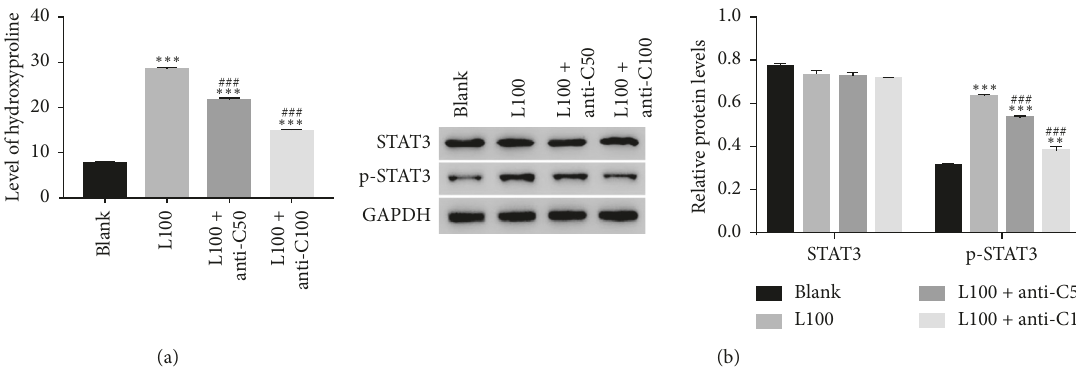
Figure 6: The antibody of CXCL16 reduced the effect of LPS on mouse LF cells. (a) The antibody of CXCL16 deeply suppressed the production of HYP in LPS cultured cells ( ∗∗∗ p < 0 . 001 vs Blank; ### p < 0 . 001 vs L100). (b) The phosphorylation of STAT3 was inhibited by the antibody of CXCL16 in LPS cultured cells ( ∗∗ p < 0 . 01 vs Blank, ∗∗∗ p < 0 . 001 vs Blank; ## p < 0 . 01 vs L100, ### p < 0 . 001 vs